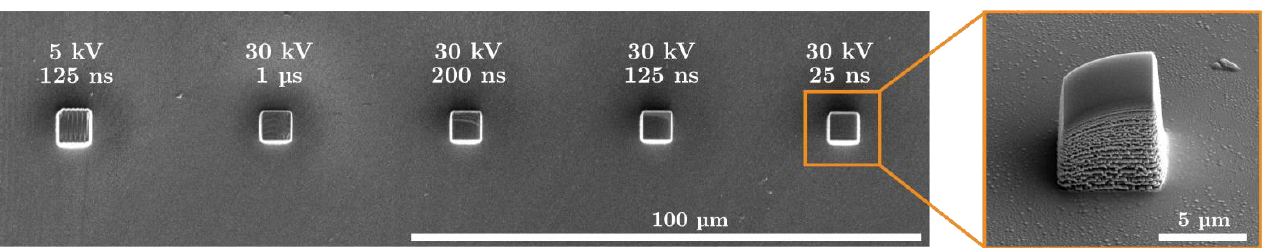
Figure 3. Illustration of five FIBID pads, each with a dimension of about 5 × 5 × 5 µ m 3 . On the one hand, the dwell time is varied between 25 ns and 1 µ s, and on the other hand, the acceleration voltage is set to 5 or 30